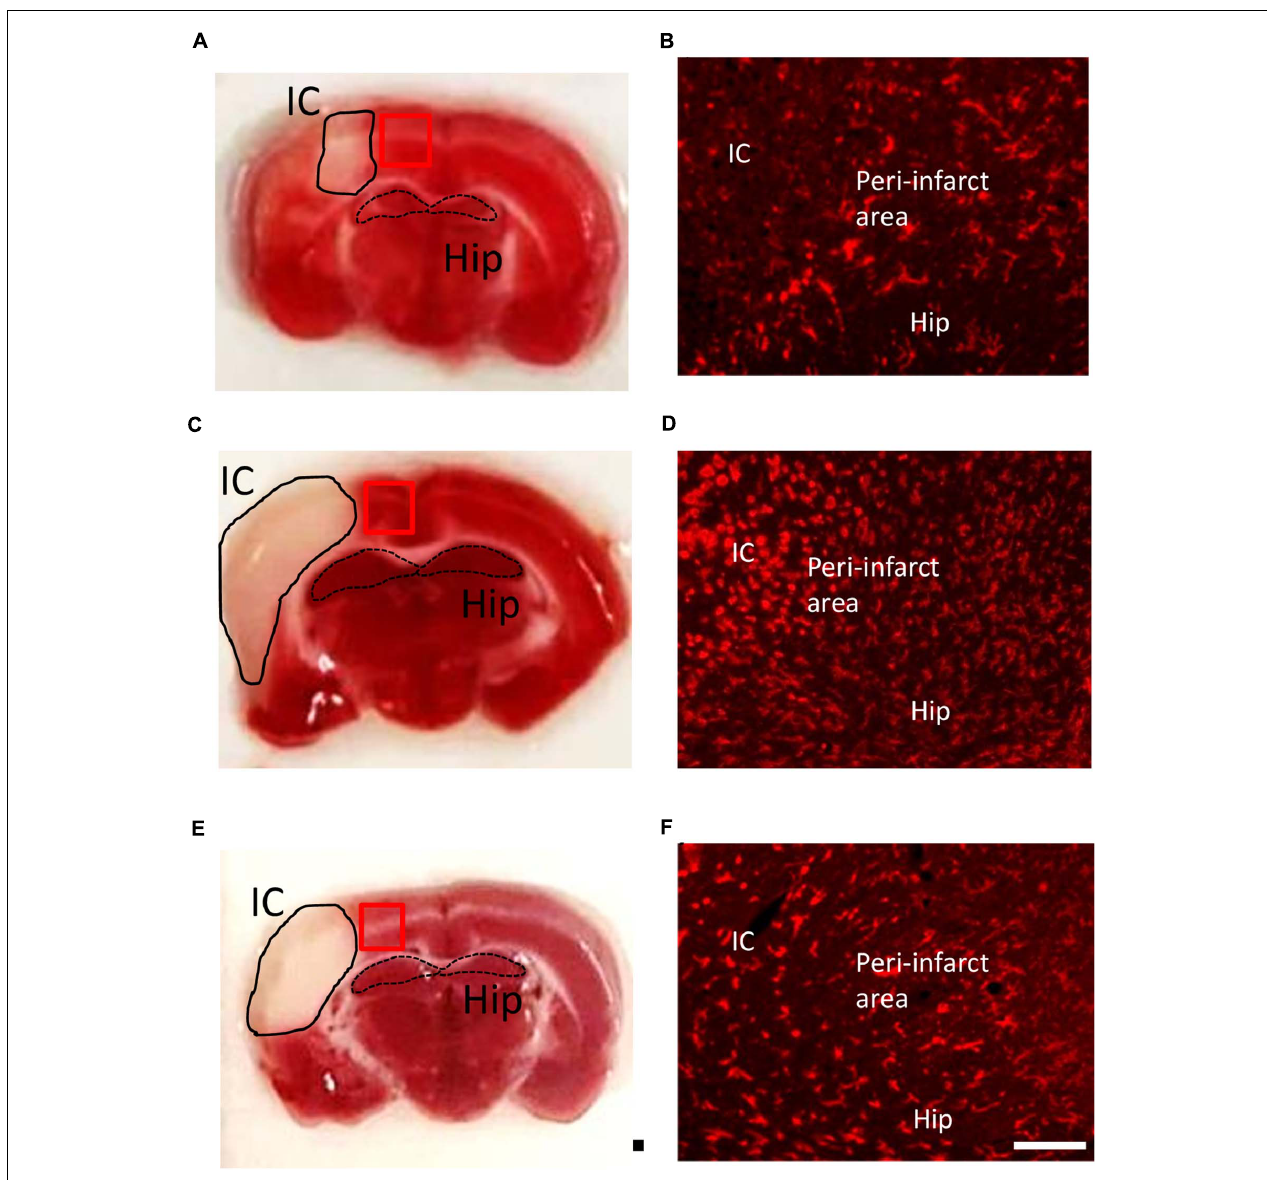
FIGURE 3 | Time course of microglia/macrophage activation after cortical stroke. Representative images of TTC staining and immunostaining of all microglia/macrophages (CD11b) from ischemic core (IC), peri-infarct area, and hippocampus (Hip) coronal sections at 1 (A,B) , 2 (C,D) , and 7 (E,F) days after 90-min dMCAo in rats. The morphological changes and increasing number of microglia/macrophages were obviously found at 2 days after ischemia. Scale bar is 50 µ m (immunofluorescence of CD11b) and 5000 µ m (TTC